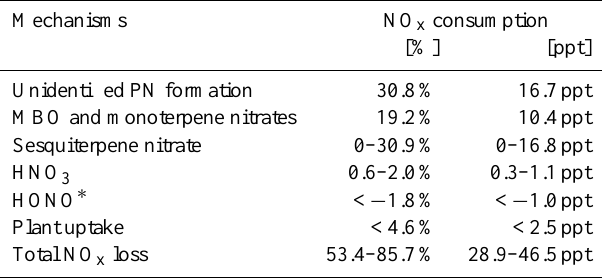
Table 2. Possible within canopy NO x consumption